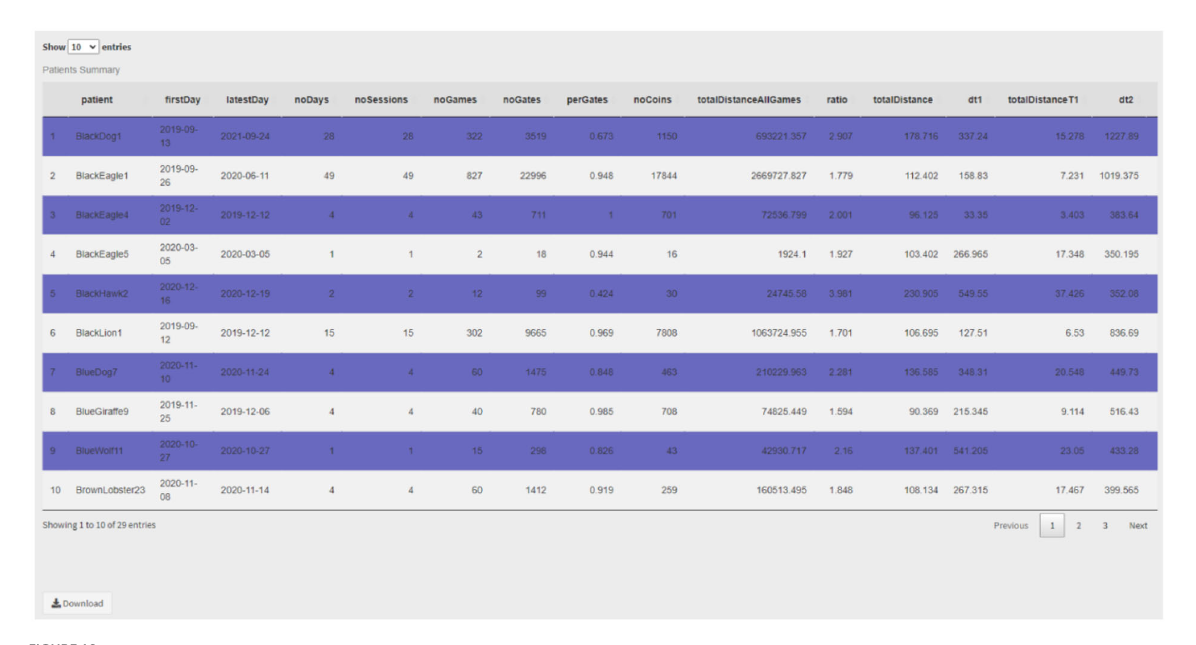
FIGURE10 Brief statistics table for the complete set of monitored patients.